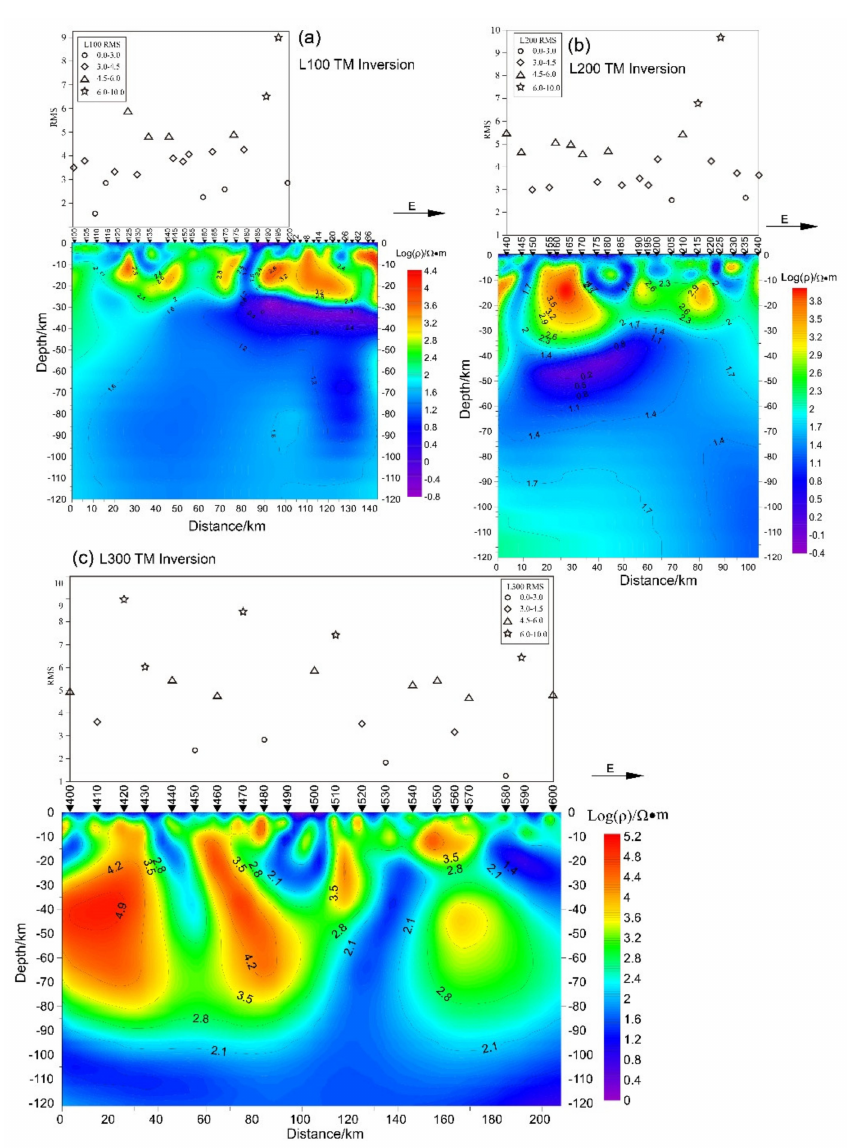
Figure 7. RMS distribution along these three profiles for the original 2D